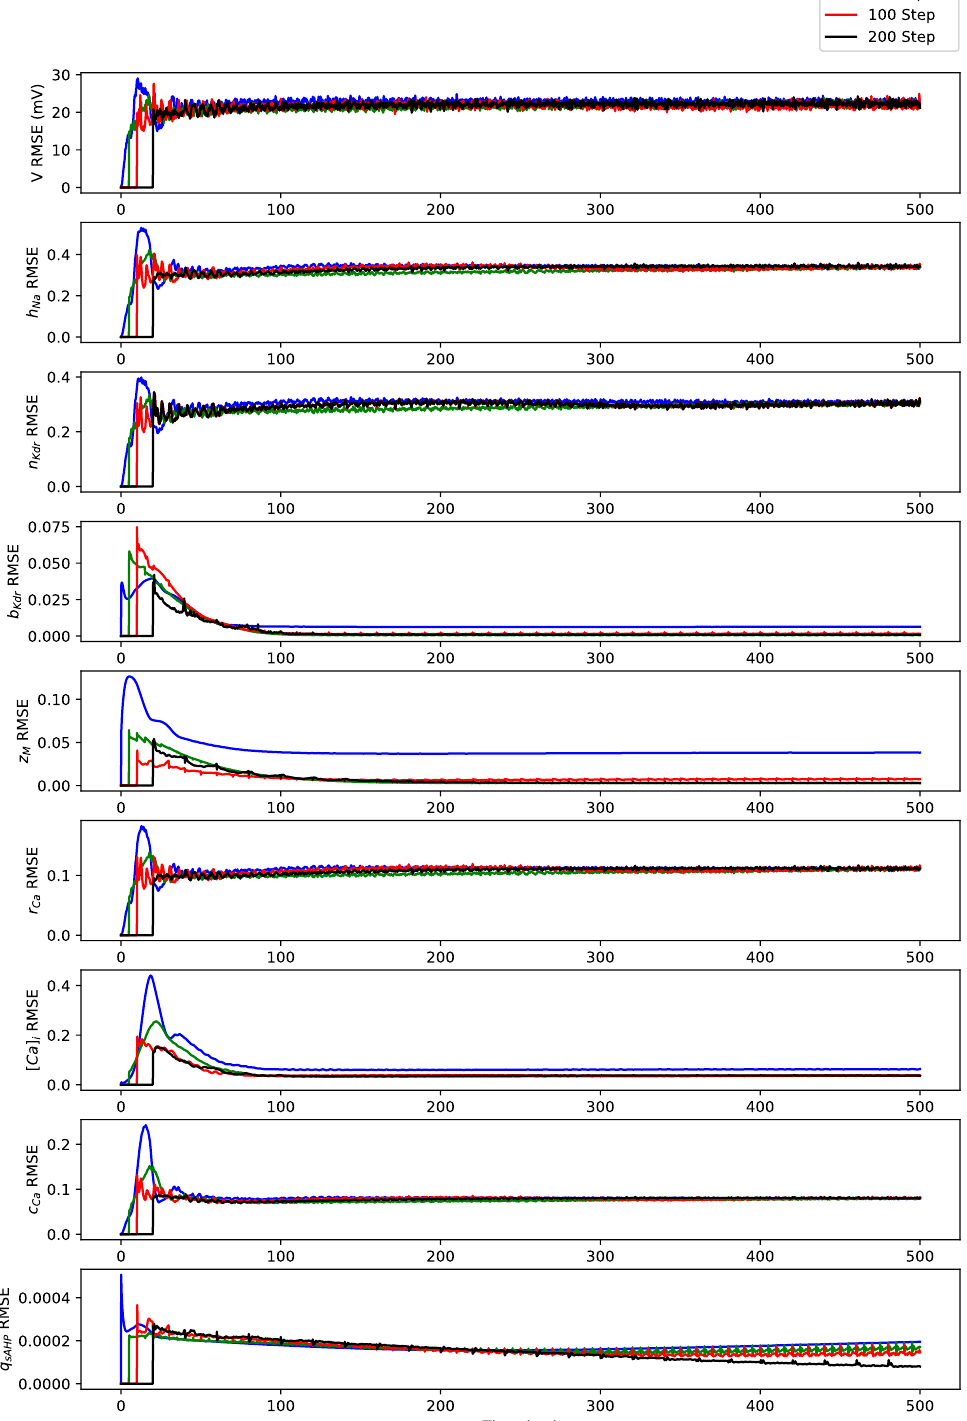
Figure A5. The root mean squared error (RMSE) versus simulation time for 5000 independent realizations, drawn from the predicted membrane potential trajectories of 50 randomly selected stimulating currents from a Uniform distribution U ( 2.3,3.0 ) and 100 random initial conditions for each stimulating